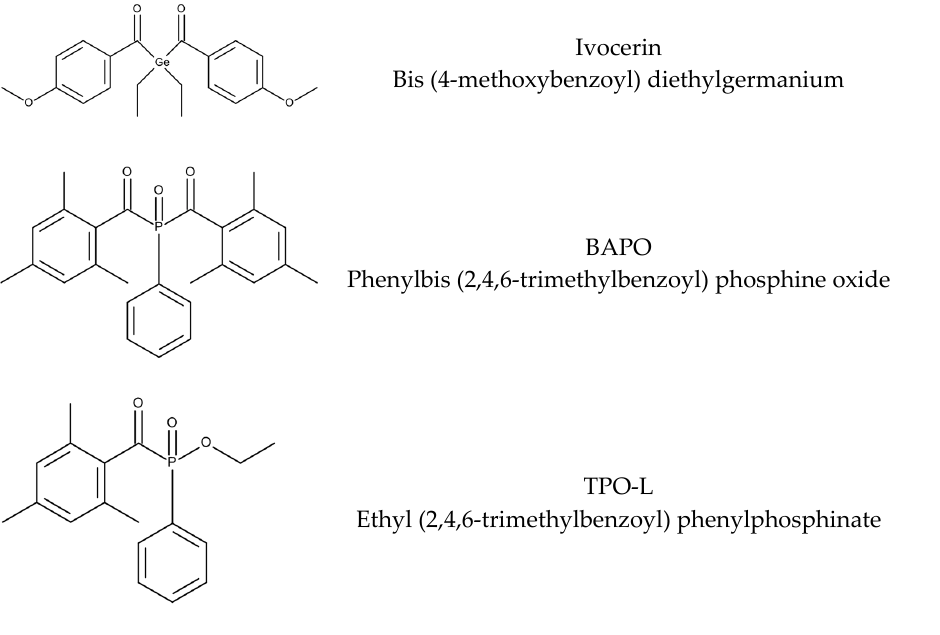
Figure 9. Photoinitiators used in this study.